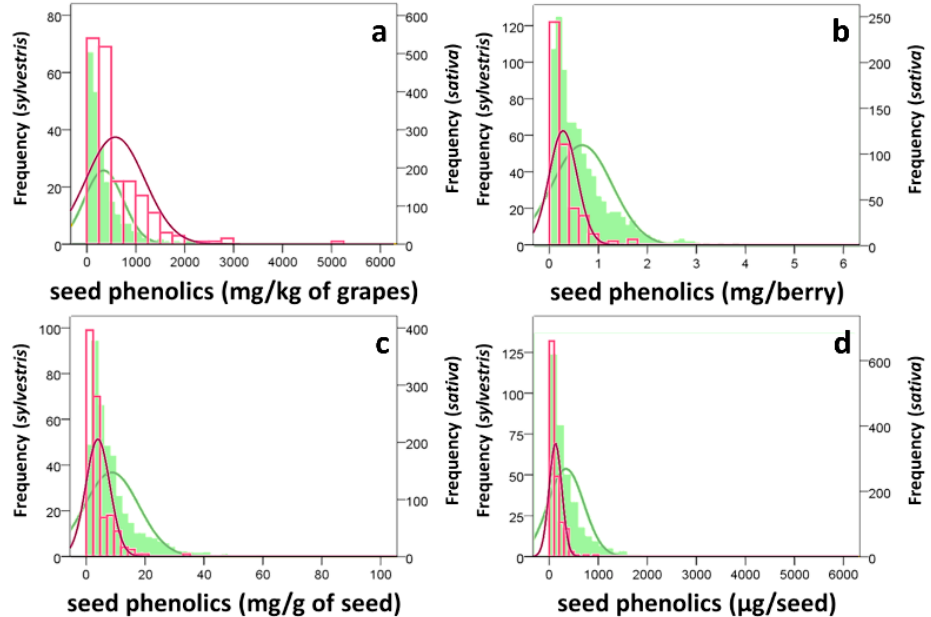
Figure 4. Seed phenolics in Vitis vinifera subsp. sylvestris (in pink) and subsp. sativa (in green). Vitis vinifera subsp. sativa data are already published in Rustioni et al. [26]. ( a ): seed phenolics (mg/kg of grapes), ( b ): seed phenolics (mg/berry), ( c ): seed phenolics (mg/g of seed), ( d ): seed phenolics ( µ g/seed),